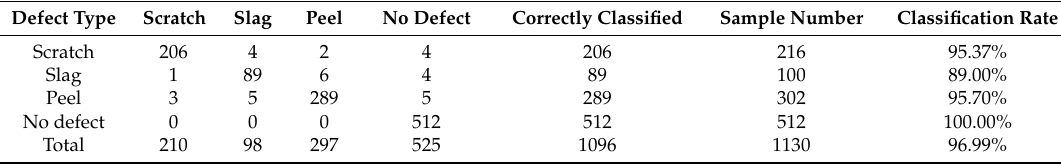
Table 5. Confusion matrix using ELM with 59-dimensional feature vectors.